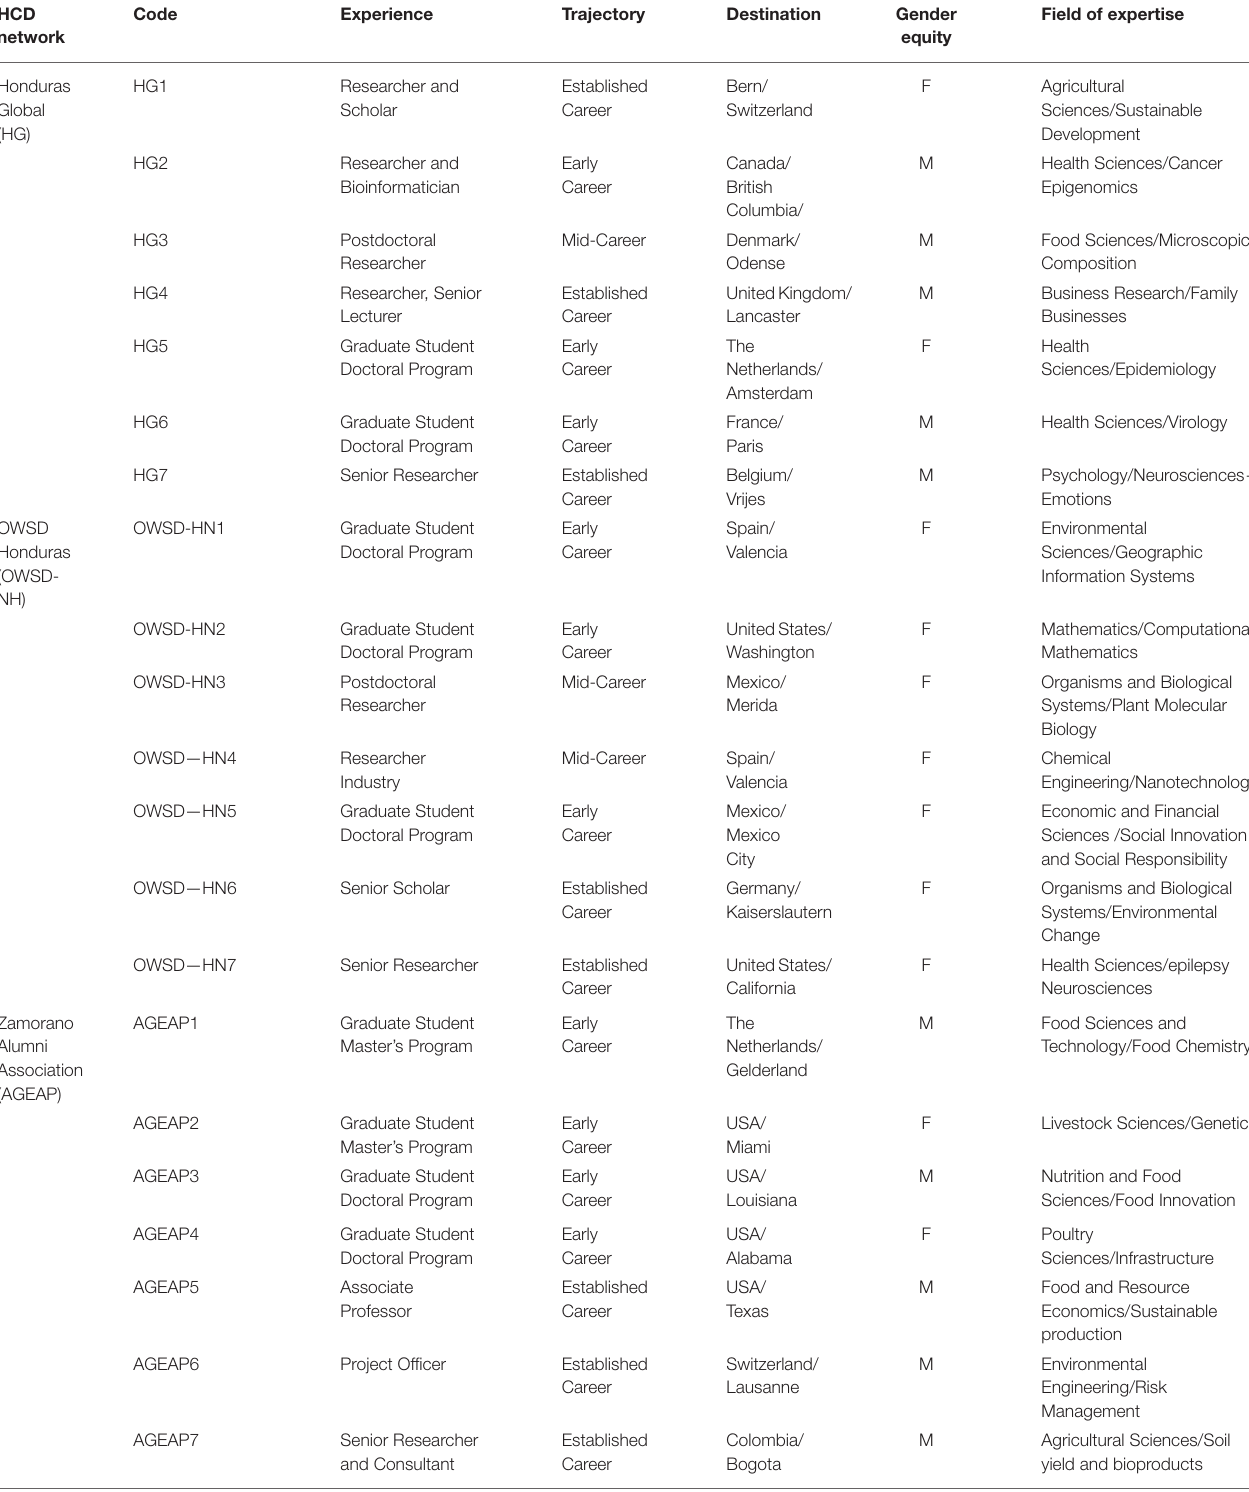
TABLE 3 | Key respondents semi-structured interviews HCD selected platforms. HCD